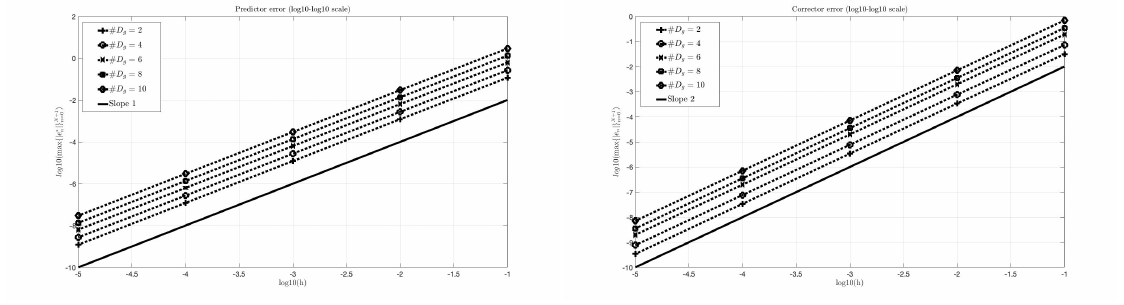
Figure 3. Evolution of the global error.